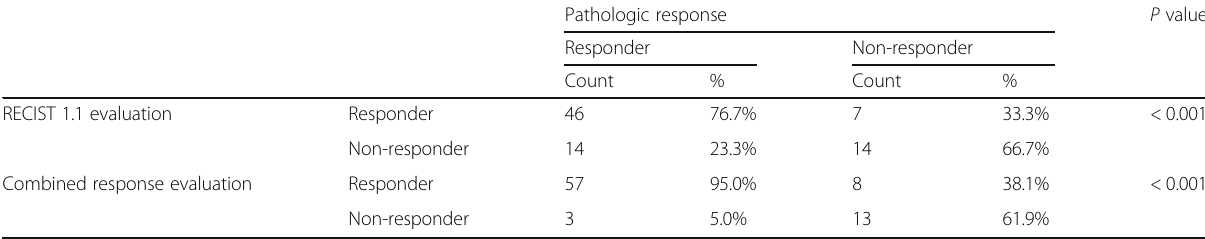
Table 6 Correlation between the radiological response and the pathological response patterns using the RECIST criteria and the combined response